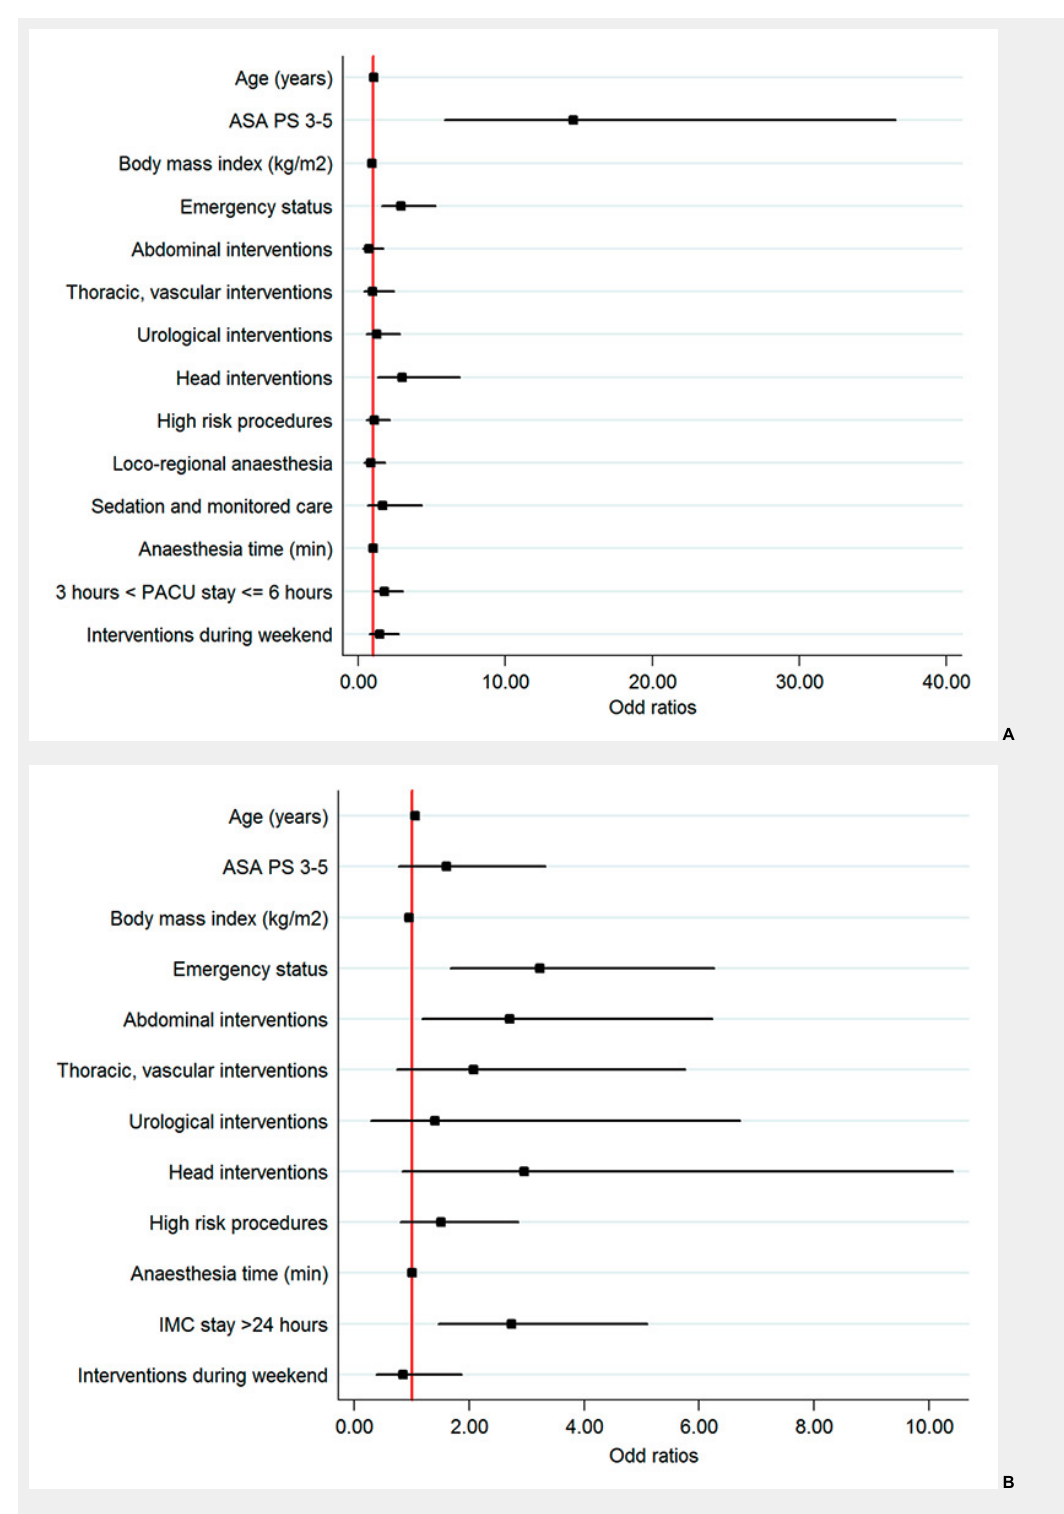
Figure 3 Odd ratios for 30-day in-hospital death in patients with PACU stay (A) and in patients with IMC stay (B) (multivariate model). PACU stay 3 hours to ≤6 hours was assessed versus PACU stay <3 hours; IMC stay >24 hours versus IMC stay 6 hours to ≤24 hours. ASA PS 3‒5 was assessed versus ASA PS 1–2; emergency (nonelective) status versus elective; abdominal, thoracic – vascular, urological, head intervention versus orthopaedic; high-risk procedures versus low- and intermediate-risk procedures; locoregional anaesthesia, sedation and monitored care versus general and combined anaesthesia; interventions during weekend versus interventions during weekdays. ASA PS = American Society of Anesthesiologists Physical Status score; ICM = intermediate care unit; PACU = post anaesthesia care